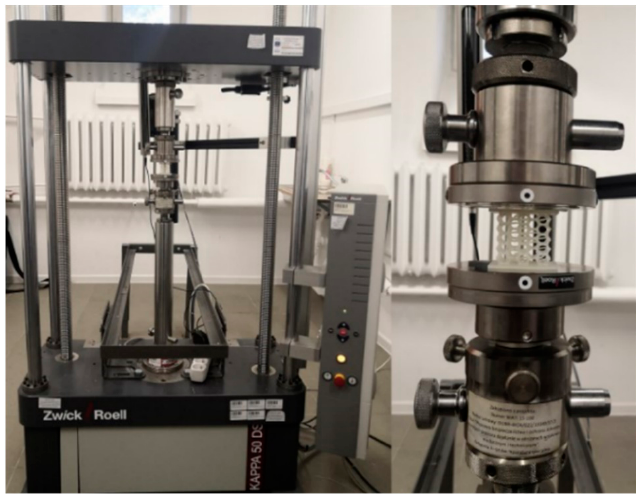
Figure 5. The testing machine with a specimen placed in it.